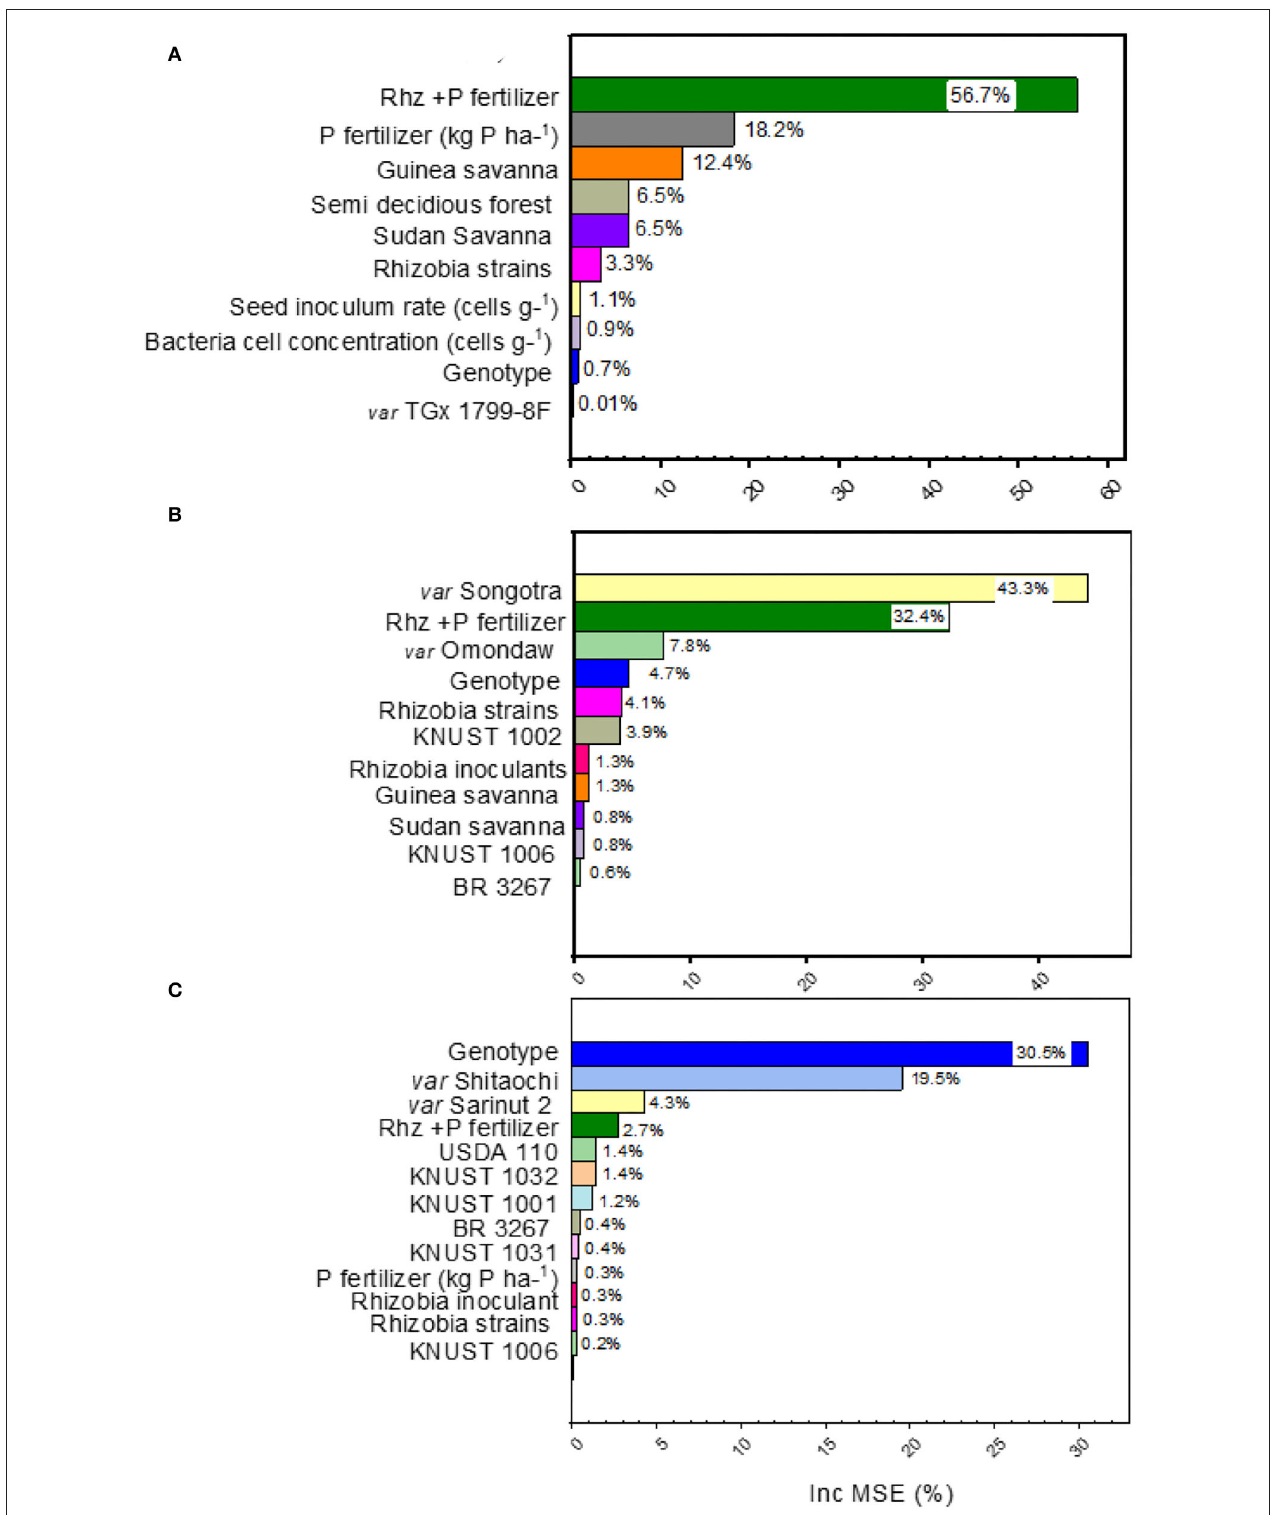
FIGURE 3 | Random forest results of the relative importance of different explanatory variables (rhizobia strains, legume genotype, agroecology, P application, and combined rhizobia inoculant and P application) in explaining variation to “grain yield” change of (A) soybean, (B) cowpea, and (C) groundnuts from field experimental studies in Ghana included in the present